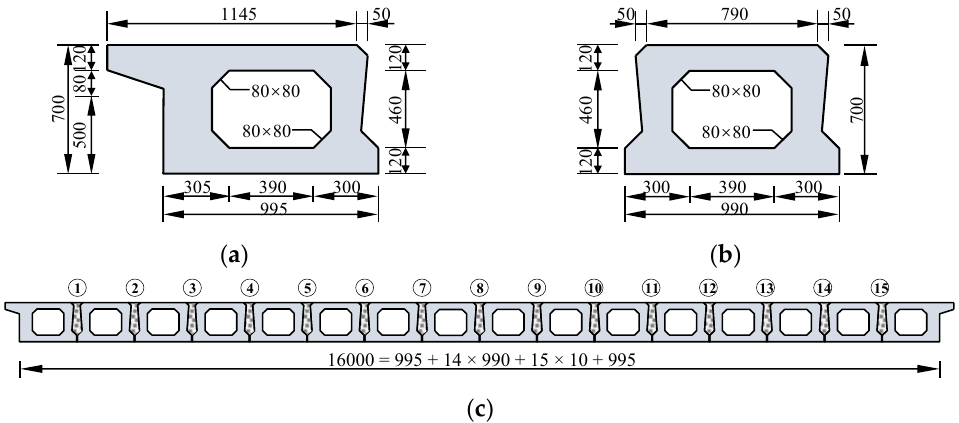
Figure 1. The transverse section of a prefabricated girder and hollow slab bridge (unit: mm): ( a ) section of side girder; ( b ) section of middle girder; ( c ) cross section. The precast hollow slab, hinge joint, and the cast-in-place layer of the bridge deck are made of C50 concrete with an elastic modulus of E = 34.5 GN/m 2 , a density of ρ = 2600 kg/m 3 , and a Poisson’s ratio of ν = 0.200. The three-dimensional solid model